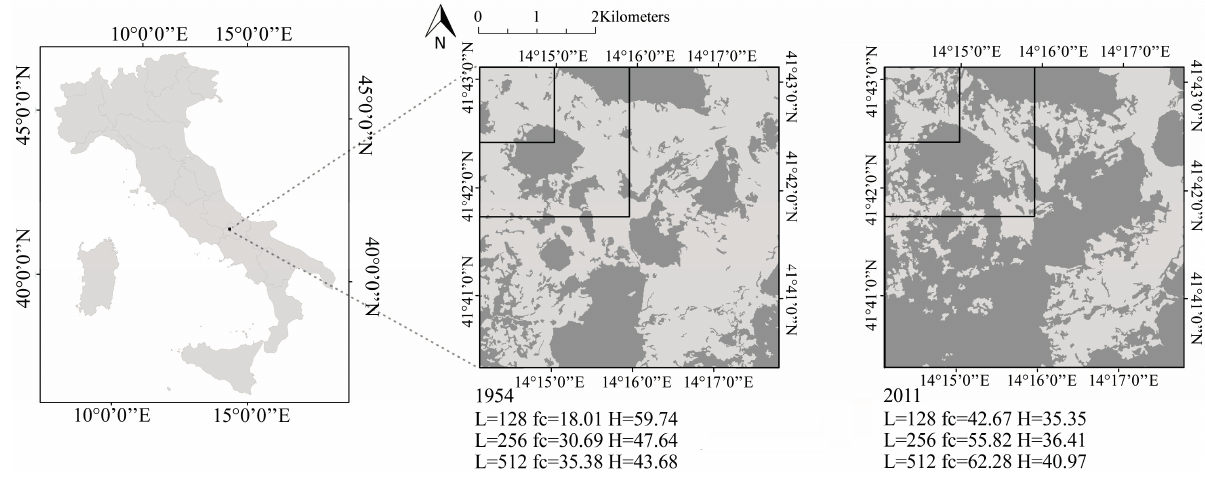
Figure 1. Location of the study area, with forest cover maps for the years 1954 and 2011 with a pixel resolution of 10 m. The multi-scale analysis was performed by expanding the extent diagonally, starting from the upper left corner of the original area. The dimension of the maps was 128 × 128, 256 × 256 and 512 × 512 pixels, corresponding to 163.84, 655.36 and 2621.44 hectares. The binary classification separates forest (dark grey) from no forest (light grey). fc is the proportion of forest cover, and H is the spatial autocorrelation or contagion of the